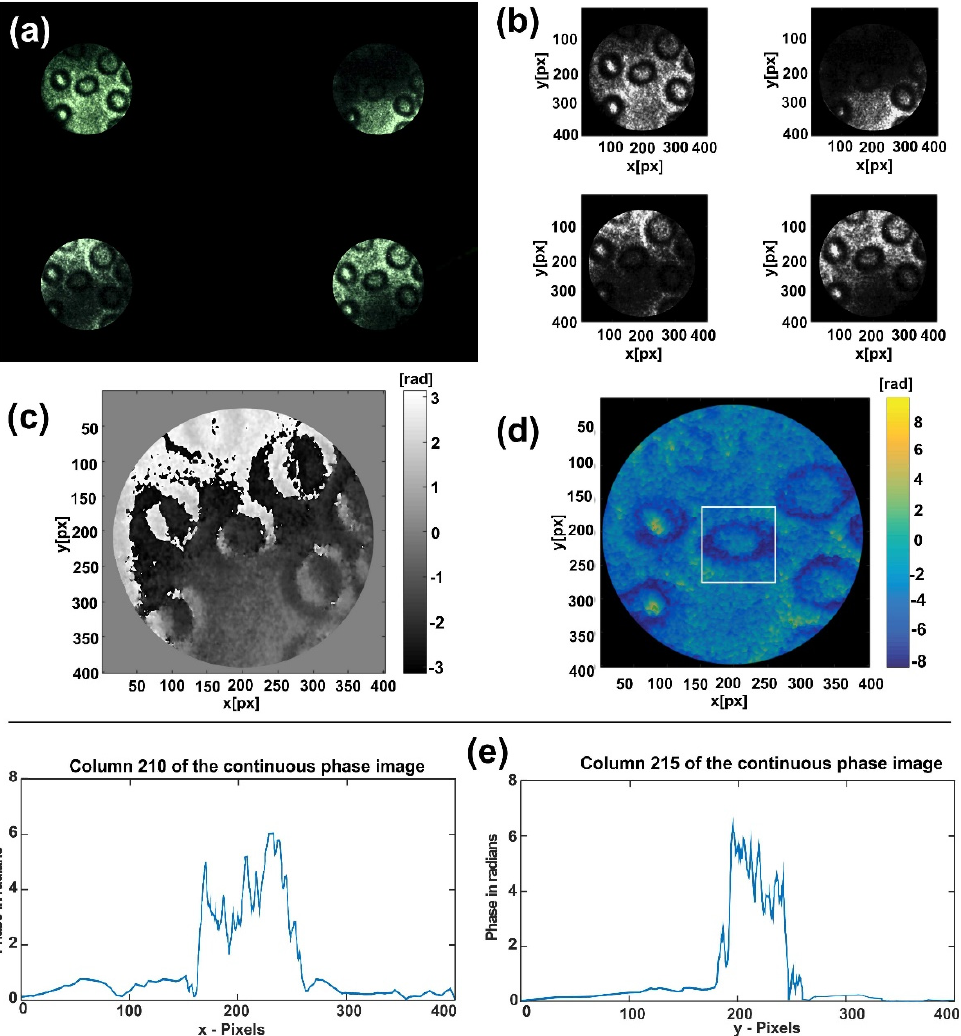
Figure 9. Red blood cells. ( a , b ) Four simultaneous patterns. ( c ) Wrapped phase. ( d ) Phase map ( e ) Transversal section of RBC.